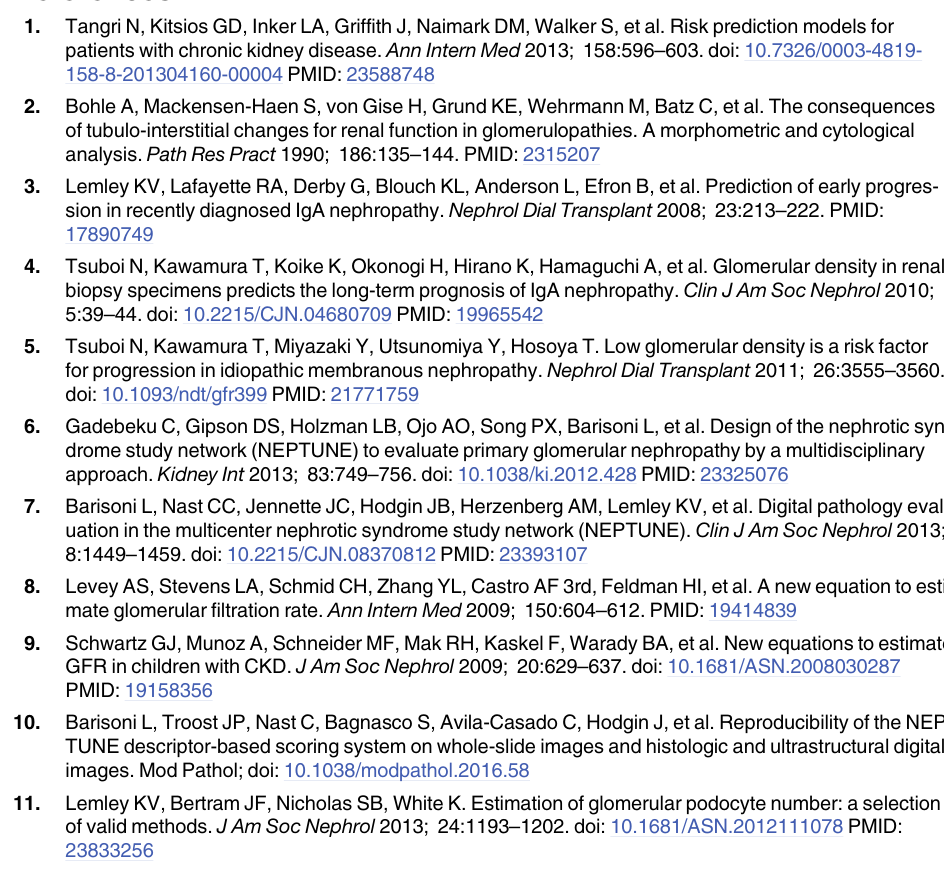
S1 Table. Morphometric, clinical and demographic data used in generalized estimating equation